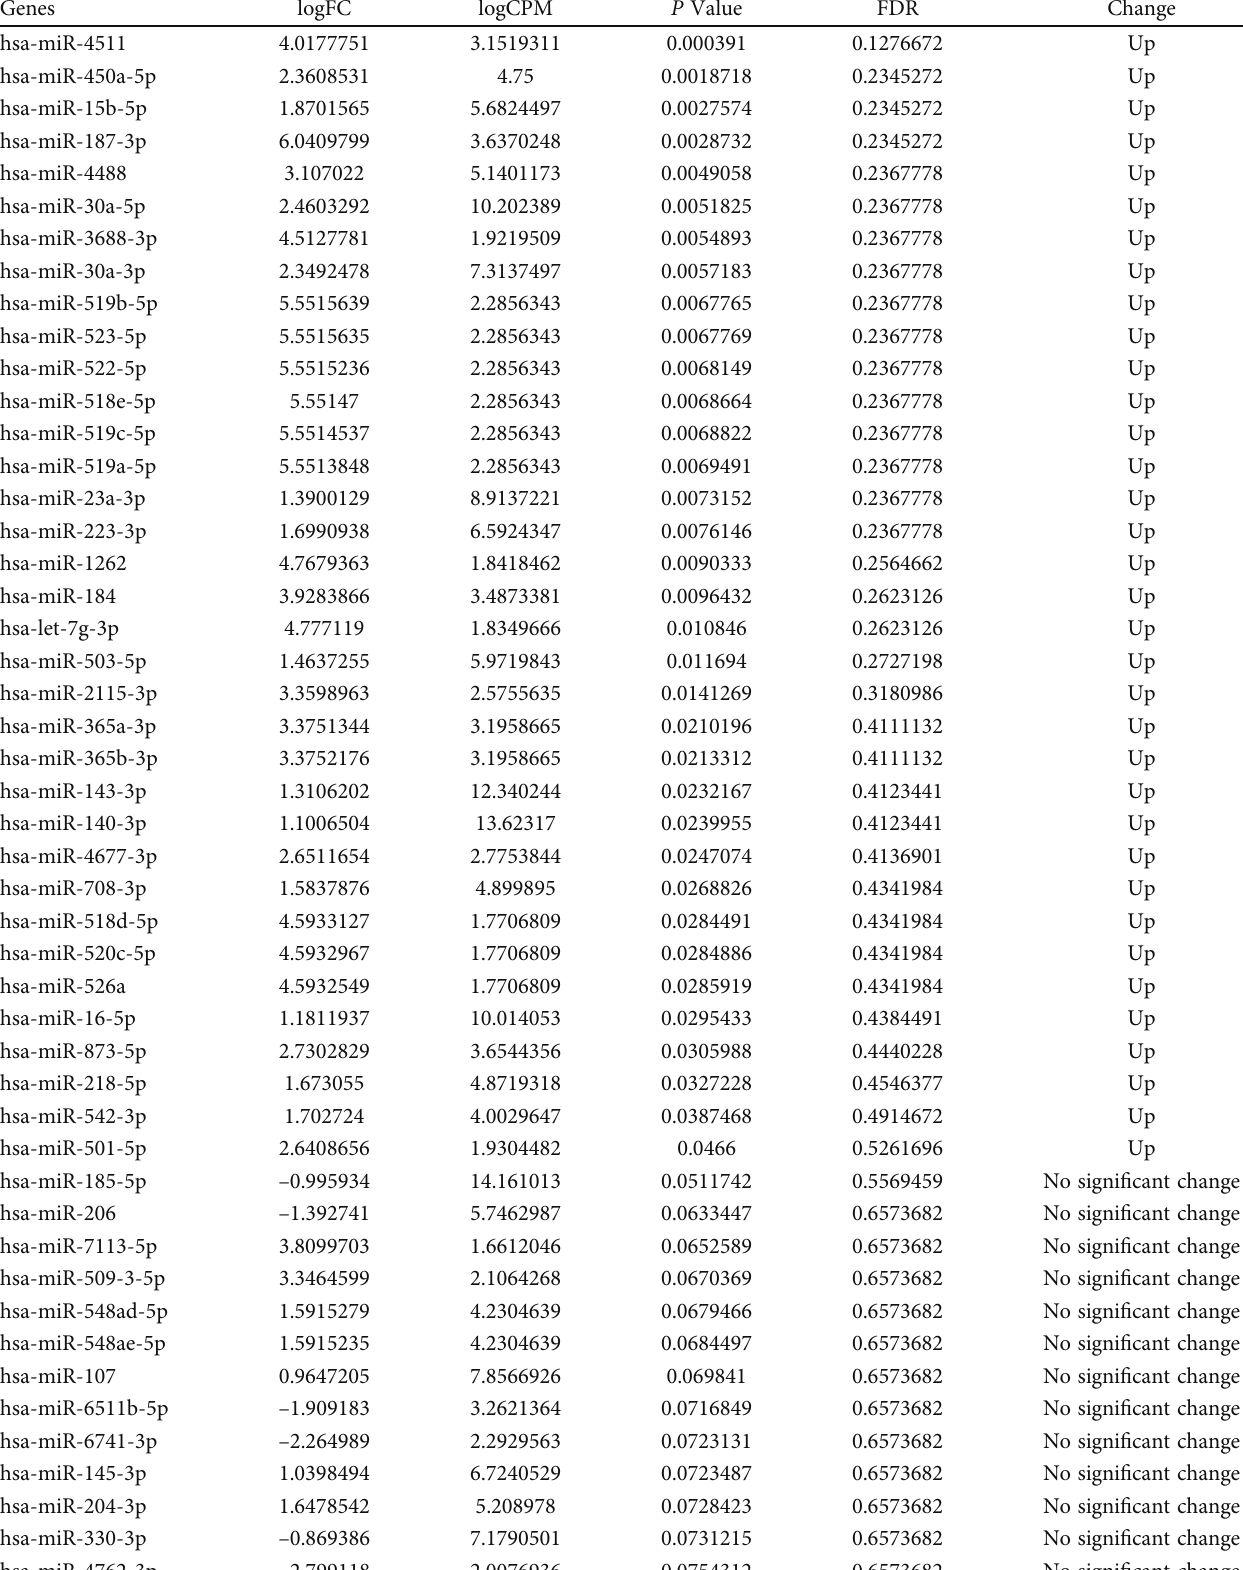
Table 1: The di ff erentially expressed miRNAs in serum exosomes between IS patients and healthy controls from GSE199942 data sets.